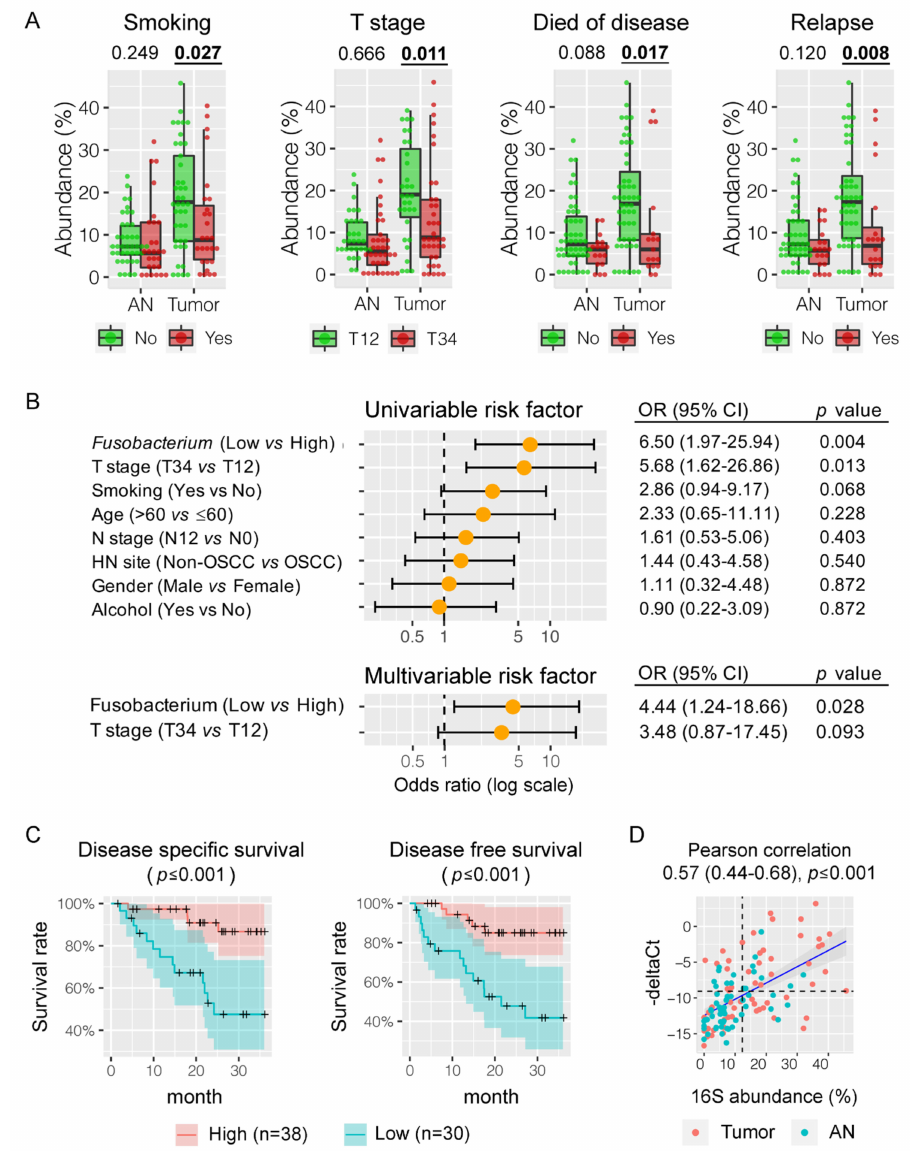
Figure 3. Association of Fusobacterium abundance with HNSCC patient outcomes. ( A ) High abundance of Fusobacterium in HNSCC tumor tissues was positively associated with non-smokers, low T classification, better disease specific survival, and lower recurrence of disease. ( B ) Both univariate and multivariate regression analyses demonstrated that the high amount of Fusobacterium was an independent predictor of HNSCC disease specific survival. ( C ) A higher relative abundance of Fusobacterium in tumor tissue was correlated with improved 3-year disease-specific survival (DSS) and disease-free survival (DFS). ( D ) Quantitative PCR (qPCR) targeting the nusG gene confirmed the high abundance of Fusobacterium nucleatum in HNSCC tumor